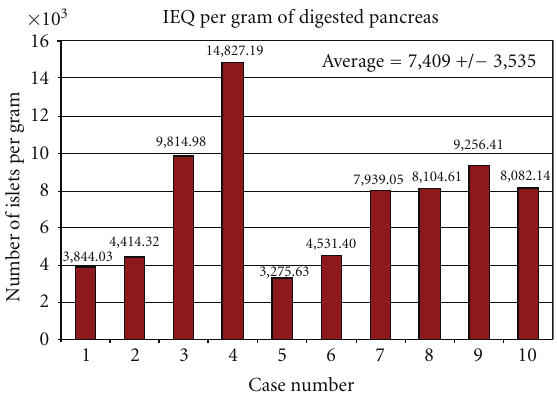
Figure 2: Islet yield expressed as islet equivalent numbers per gram of pancreatic tissue actually